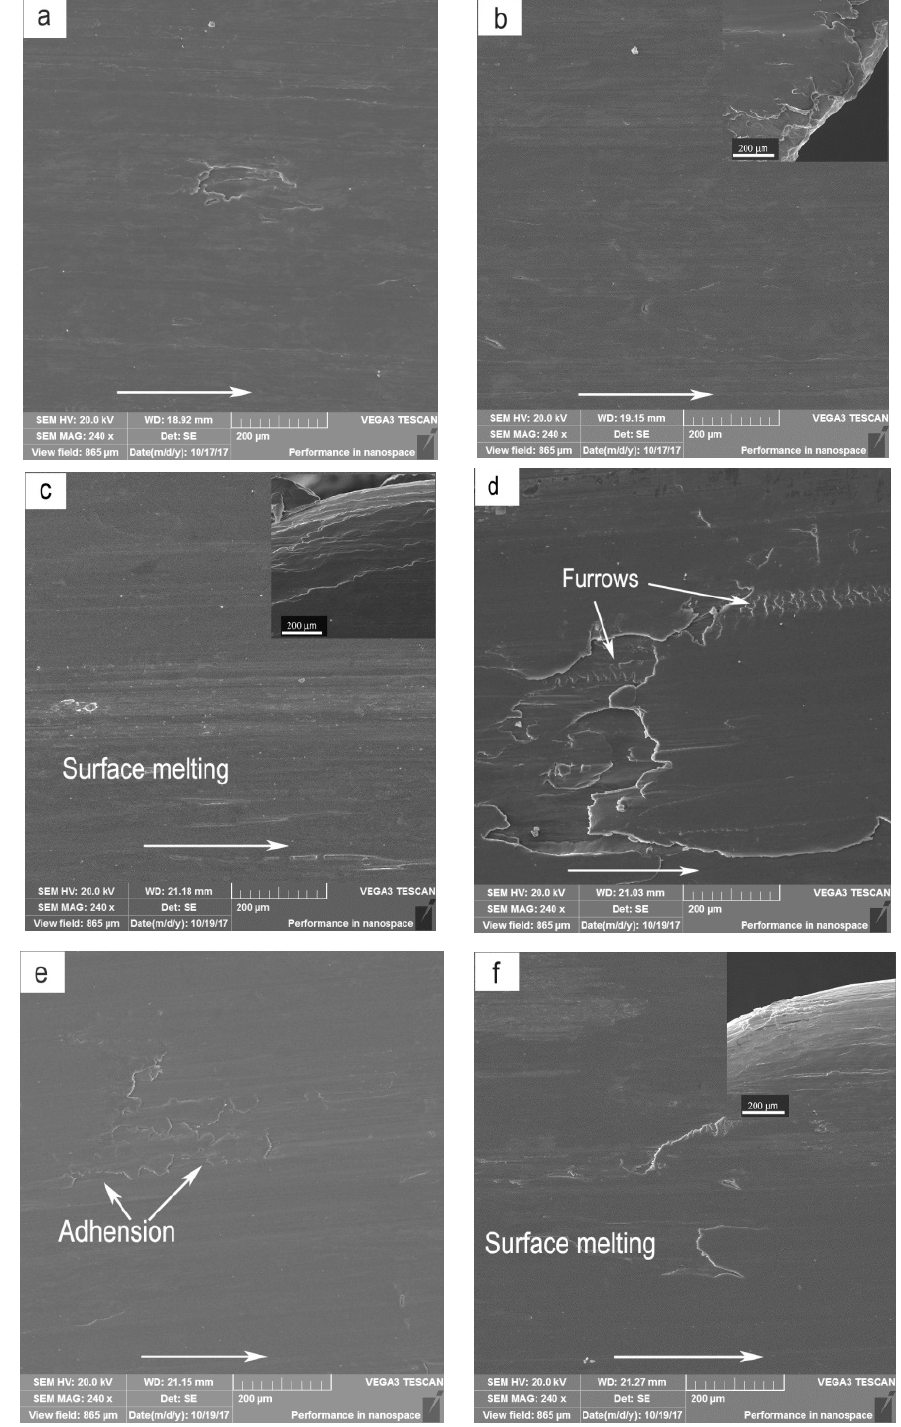
Figure 4. Worn surface morphologies of Mg97Zn1Y2 alloy at different applied loads and test temperatures under 3.0 m/s: ( a ) 20 N, 100 °C, ( b ) 50 N, 100 °C, ( c ) 80 N, 100 °C, ( d ) 20 N, 150 °C, ( e ) 50 N, 150 °C, ( f ) 80 N, 150 °C. The edge of pins is also shown at the top right corner of the figures. The arrows show the sliding direction.